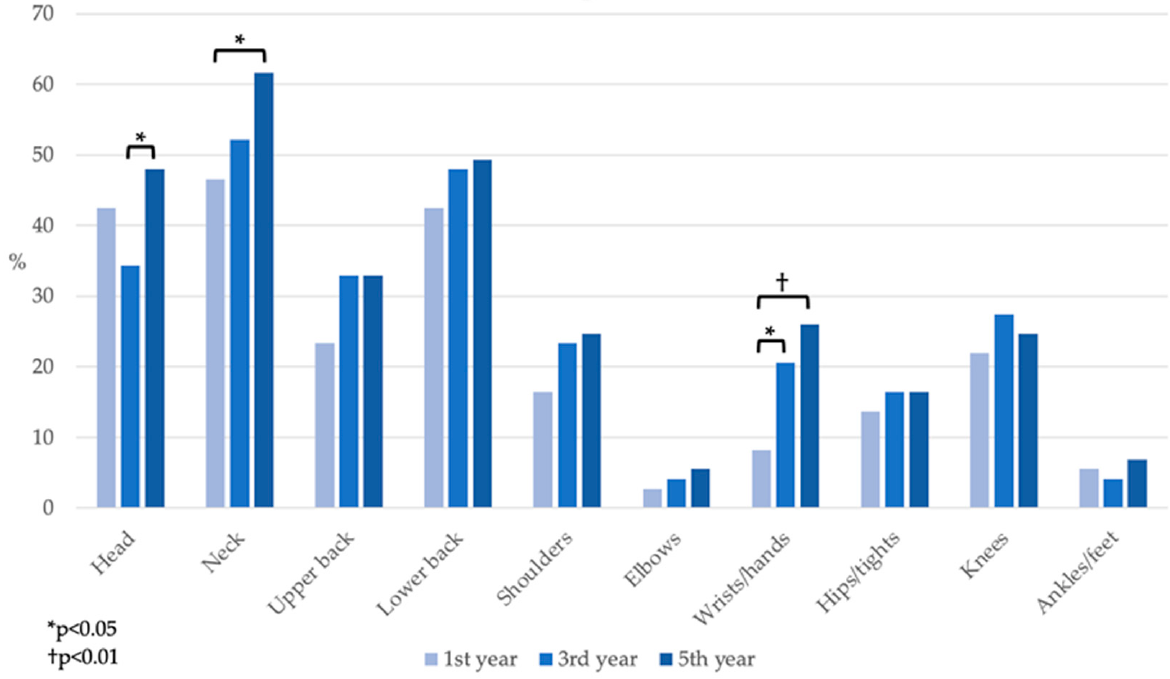
Figure 2. The development of recent pain in different body regions regardless of its intensity. The results of univariate analysis for neck and lower back pain are presented in Tables 2 and 3.